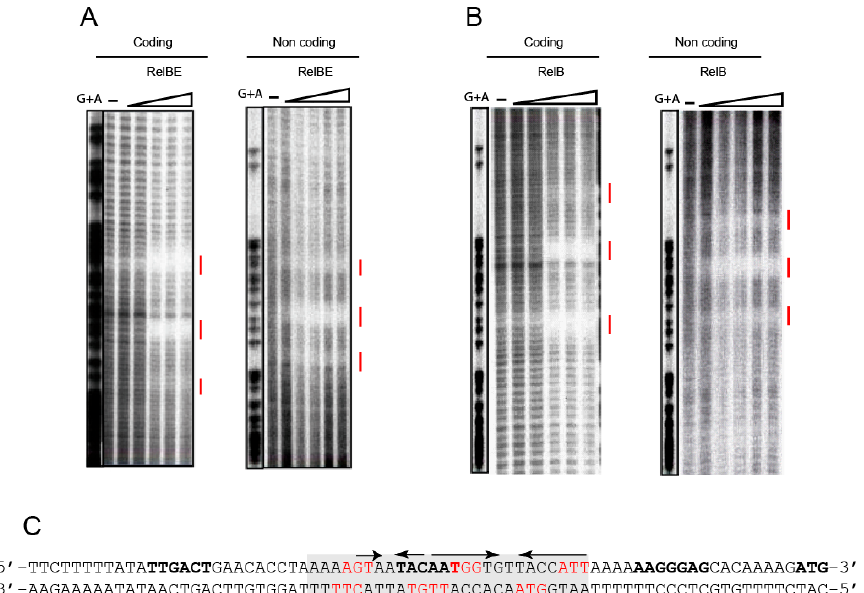
Figure 5. High-resolution footprints of RelB:RelE complex and RelB alone on their DNA target. The footprints (vertical red lines) were generated by incubation of the DNA-protein samples followed by breakage of the sugar-DNA backbone by the generation of hydroxyl radicals. RelB:RelE complex ( A ) and RelB protein ( B ) on the coding and non-coding strands of the labelled DNA fragment encompassing the P relBE promoter ( C , boldface letters). The amounts of proteins used were the same as in Figure 4. Reaction samples were run on 8% polyacrylamide gels, where ( − ) indicate the controls done in the absence of the proteins; G+A are the sequencing reactions performed on the same DNA fragment labelled at the coding and non-coding strands. ( C ) Shows a schematic representation of the OH · footprints (red letters) on the promoter DNA sequence relative to the position of the two palindromic sequences (arrows with arrowheads pointing to the symmetry axis). − 35 and − 10 boxes, transcription initiation point (+1), SD sequence and initiation codon of RelB are shown in boldface letters.